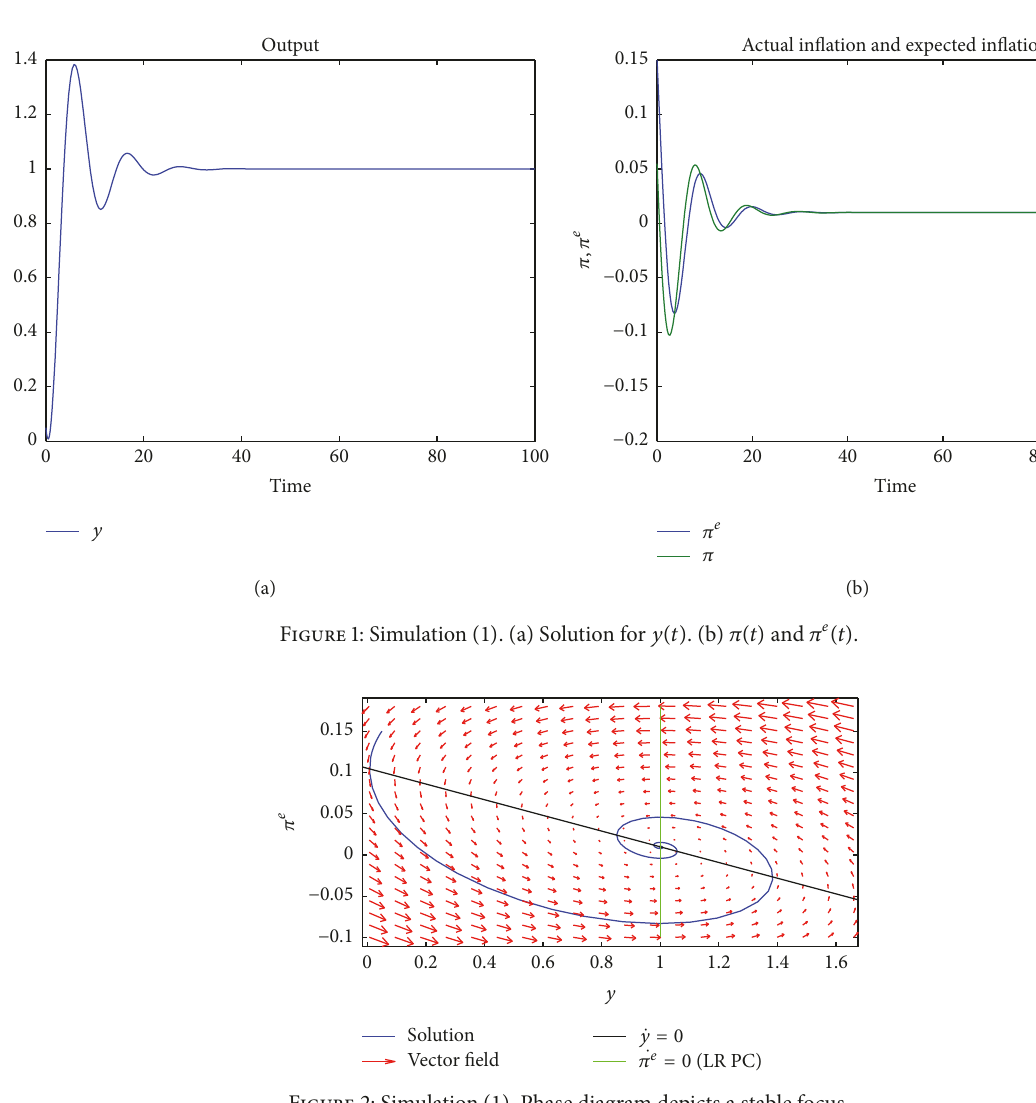
Figure 2: Simulation (1) . Phase diagram depicts a stable